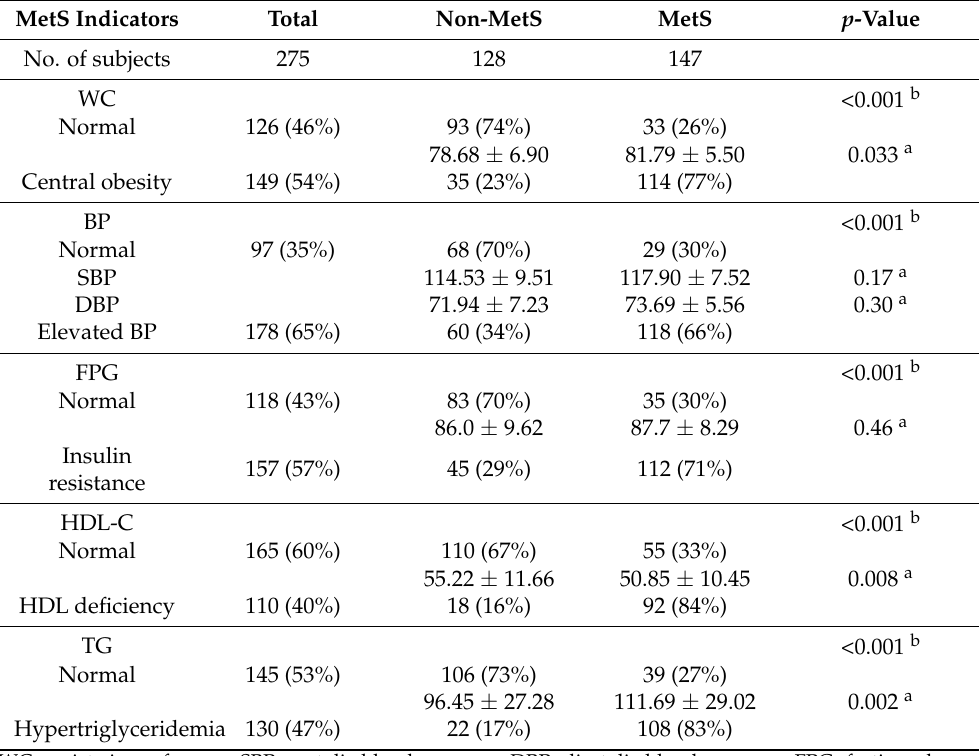
WC: waist circumference; SBP: systolic blood pressure; DBP: diastolic blood pressure; FPG: fasting plasma glucose; TG: triglycerides; HDL-C: high-density lipoprotein cholesterol; MetS: metabolic syndrome;